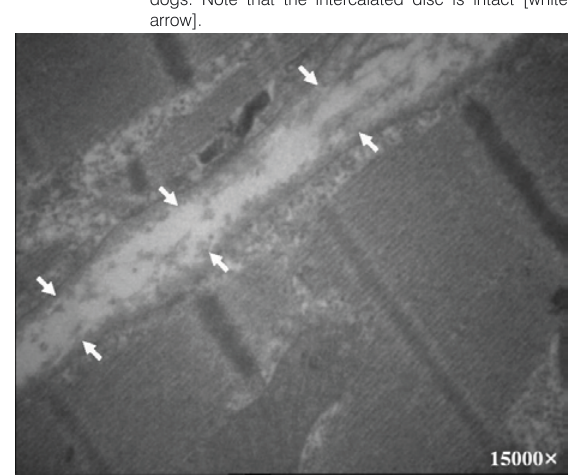
Figure 7. Electron micrographs of heart muscles of defibrillated dogs. Note that the intercalated disc is intact [white arrow].